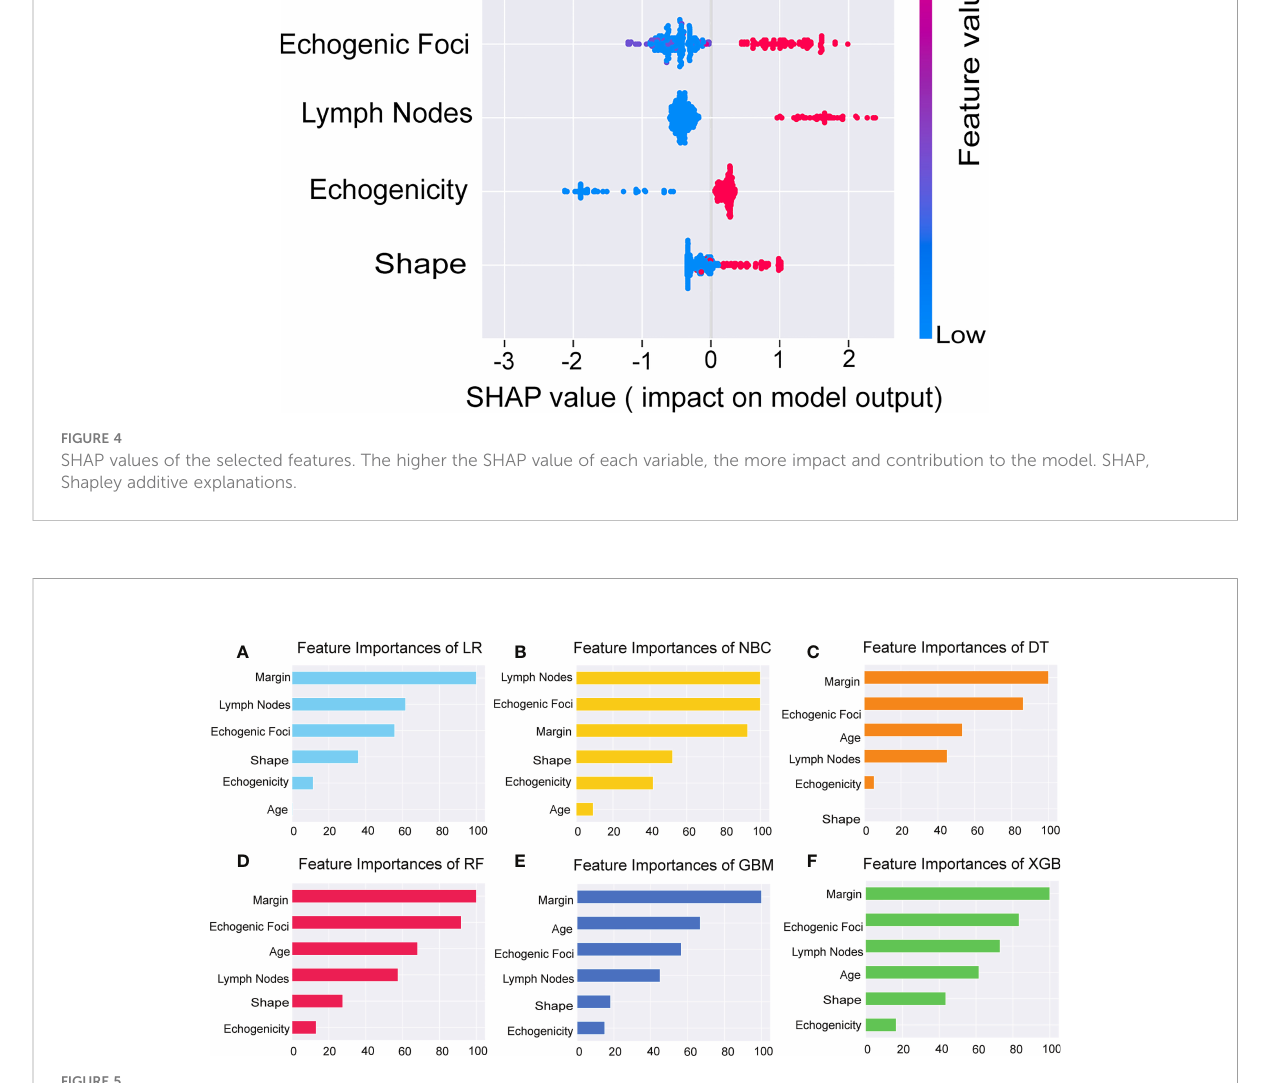
FIGURE 5 Importance of the selected features. Importance of each feature had been demonstrated and compared in the six models of LR, NBC, DT, RF, GBM, and XGBoost. LR, Logistic Regression; (A) NBC, Naive Bayes Classi fi er; (B) DT, Decision Tree; (C) RF, Random Forest; (D) GBM, Gradient Boosting Machine; (E) XGBoost, Extreme Gradient Boosting (F) .